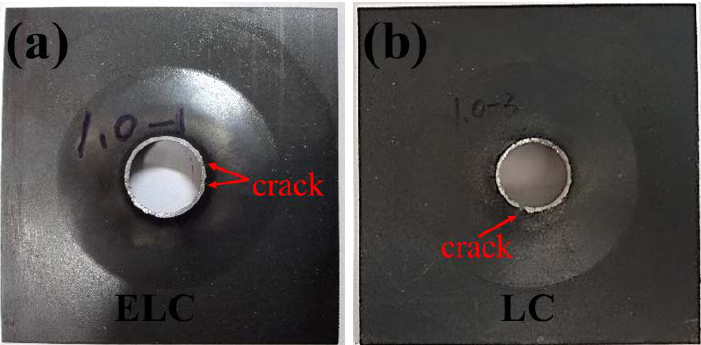
Figure 16. Photograph after hole expanded with different C content: ( a ) ELC; ( b ) LC.